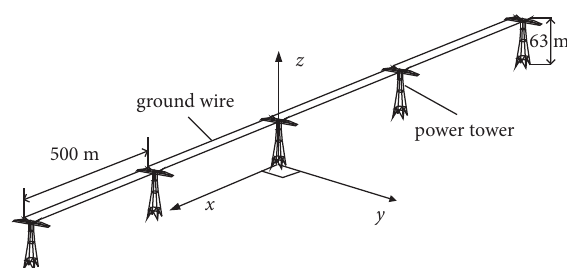
Figure 5: Model for calculation of induced current on PTL in 1.7